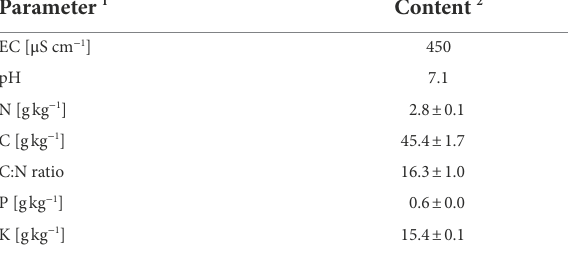
TABLE 1 Characteristics of the experimental